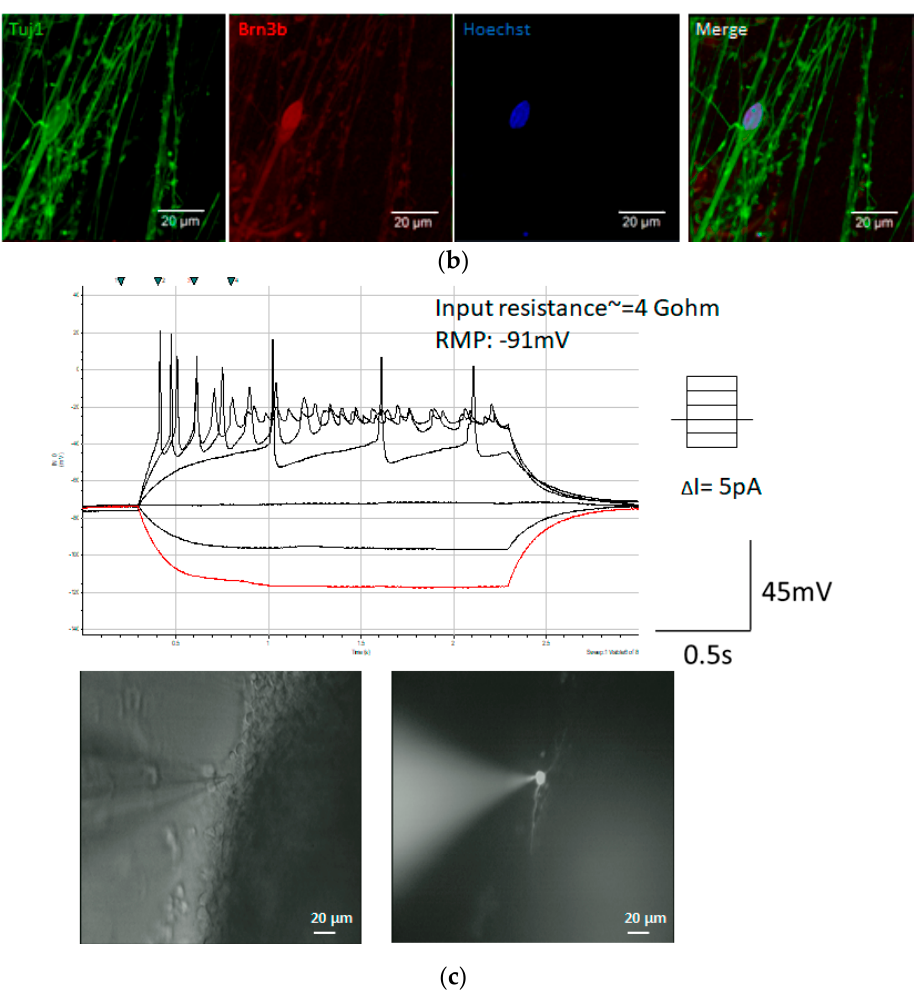
Figure 2. RGC neurite outgrowth from optic vesicles. ( a ) Images of RGCs after dissociation from optic vesicles from Day 0 to Day 10. hiPSC-derived RGC displayed long axon-like structure. Scale bar = 10 µ m; ( b ) the hiPSC-derived cells were stained by RGC specific markers, Math5, and Brn3b as well as the marker of neural cytoskeleton, Tuj1; ( c ) RGCs of Day 20 were filled with Rhodamin under fluorescence illumination ( bottom panel ). The complete I-V curve was analyzed by patch clamp. The red line shows the response of the first current injected into the cell and black lines indicate the response of the other different currents to the cells ( up panel ). The firing pattern of action potentials showed in the middle column, suggesting that RGCs became mature after isolation for 20 days.